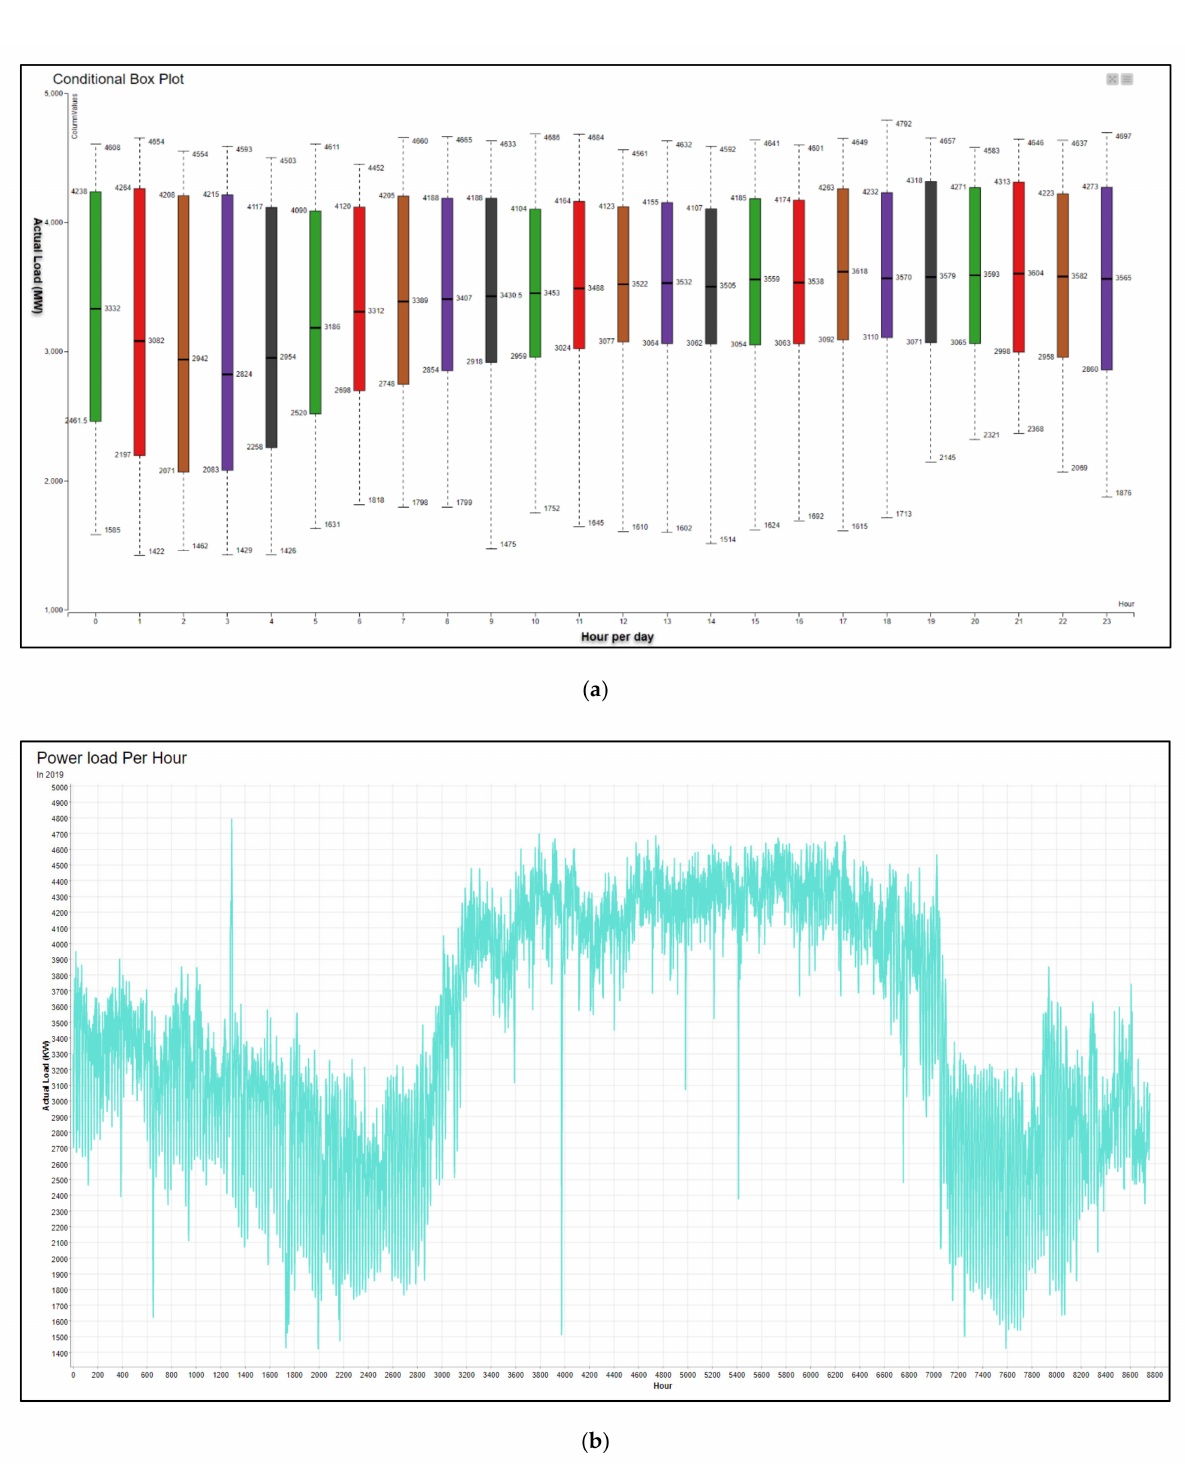
Figure 15. ( a ) Hourly Baghdad Governorate Load Distribution (MW) in 24-Hour Box-plot; ( b ) Hourly Baghdad Governorate Load Distribution (KW) for